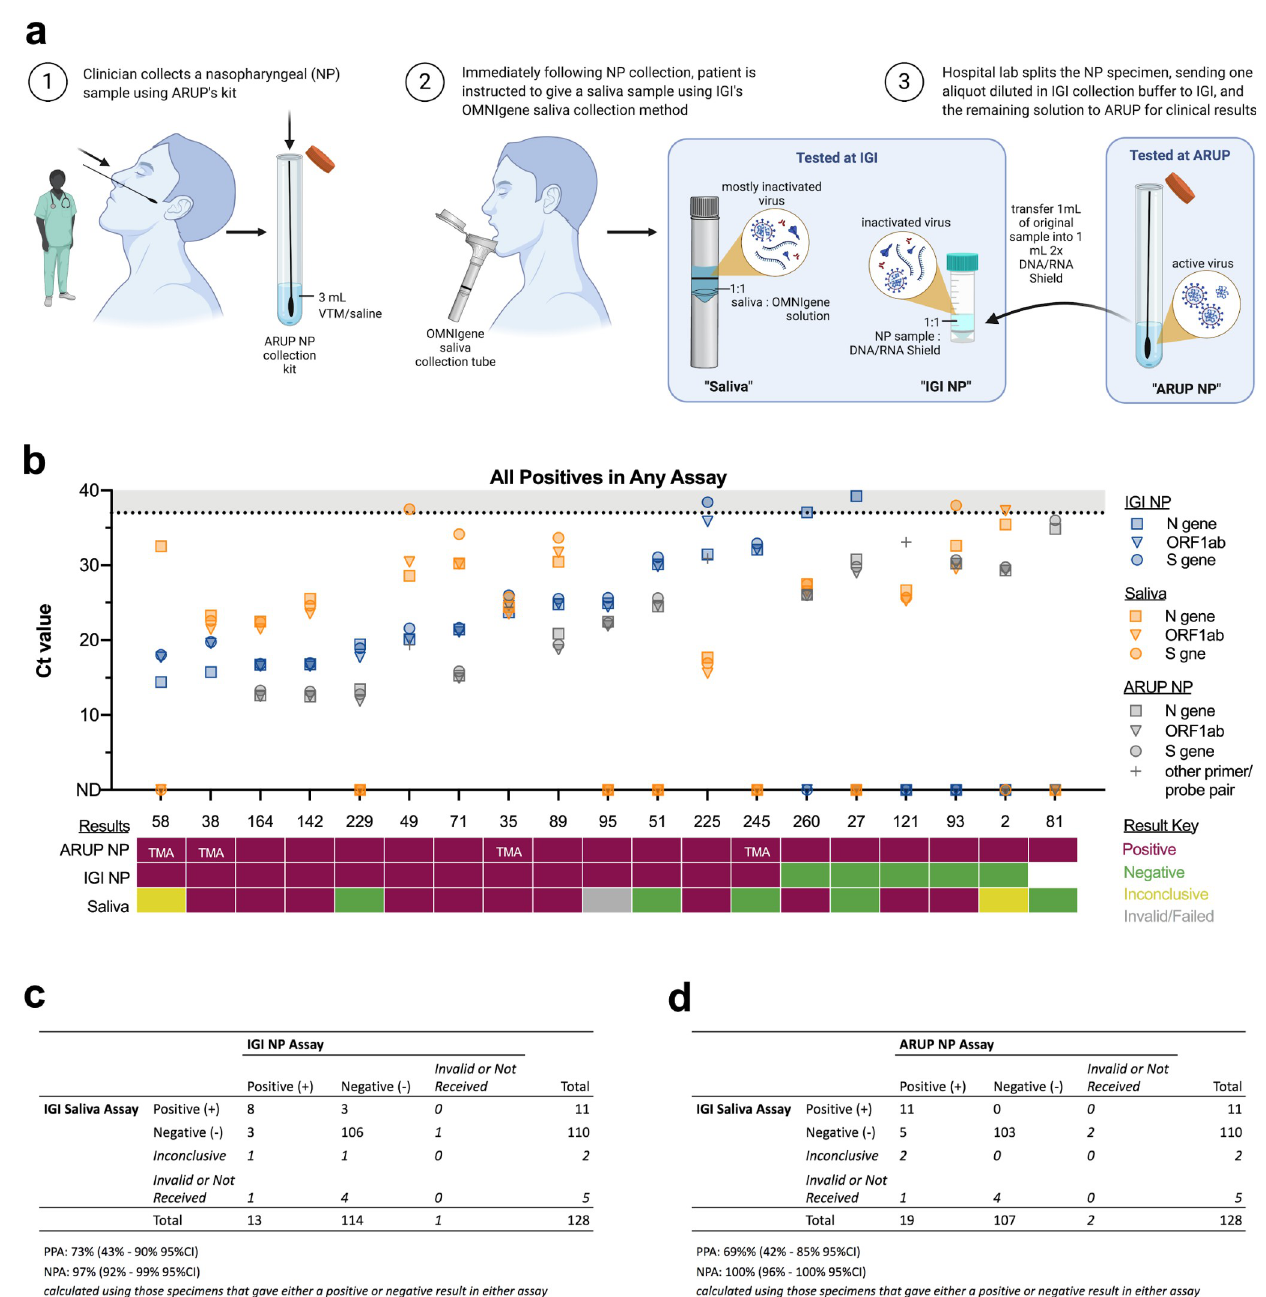
Fig 5. Clinical concordance between IGI FAST saliva and NP swab samples. The IGI partnered with Washington Hospital Healthcare System (WHHS) to collect paired nasopharyngeal (NP) swab and saliva specimens to assess the concordance between NP swab and saliva-based tests for detection of SARS-CoV-2. a, A schematic of how paired samples were collected and split for analysis. Note that undiluted NP samples were analyzed at ARUP Laboratories (ARUP NP) whereas NP samples analyzed at IGI (IGI NP) were diluted 1:1 with DNA/RNA Shield prior to extraction. b, Viral Ct values for IGI NP, saliva samples, and ARUP (where available) (top) and the final result of ARUP NP, IGI NP, and saliva samples (bottom). TMA indicates the sample was analyzed using transcription-mediated amplification, thus no Ct values were generated. Samples were sorted by the IGI NP N gene Ct value. As only positive samples are presented, MS2 Ct values were omitted for clarity. Ct values > 37 are shaded in gray. Undetected Ct values are plotted as zero and designated by “ND”, not detected. An aliquot of the NP sample for patient 81 was never received by IGI. c, Concordance between the IGI saliva and IGI NP and d, IGI saliva and ARUP NP assays. Note: some individual samples had no result (invalid or no sample/result received) and were thus left out of Positive Percent Agreement (PPA) and Negative Percent Agreement (NPA) calculations. Figure made with Biorender.